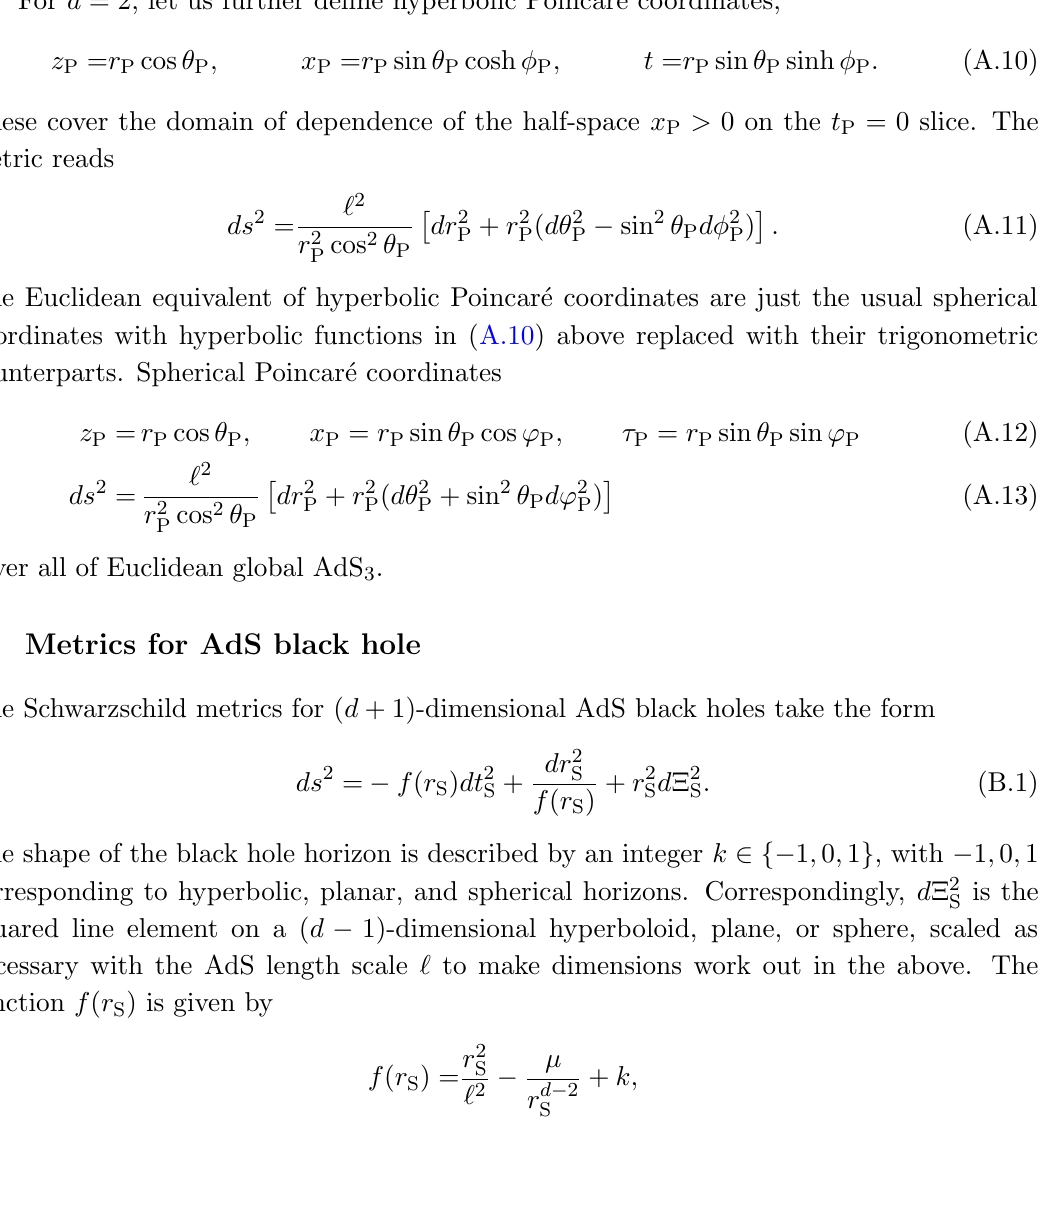
Figure 9. The Poincar´e coordinates ( t P , z P , x i the Poincar´e patch, shown in green. The entire solid cylinder is covered by the global coordinates ( t g , ρ g , Ω i g